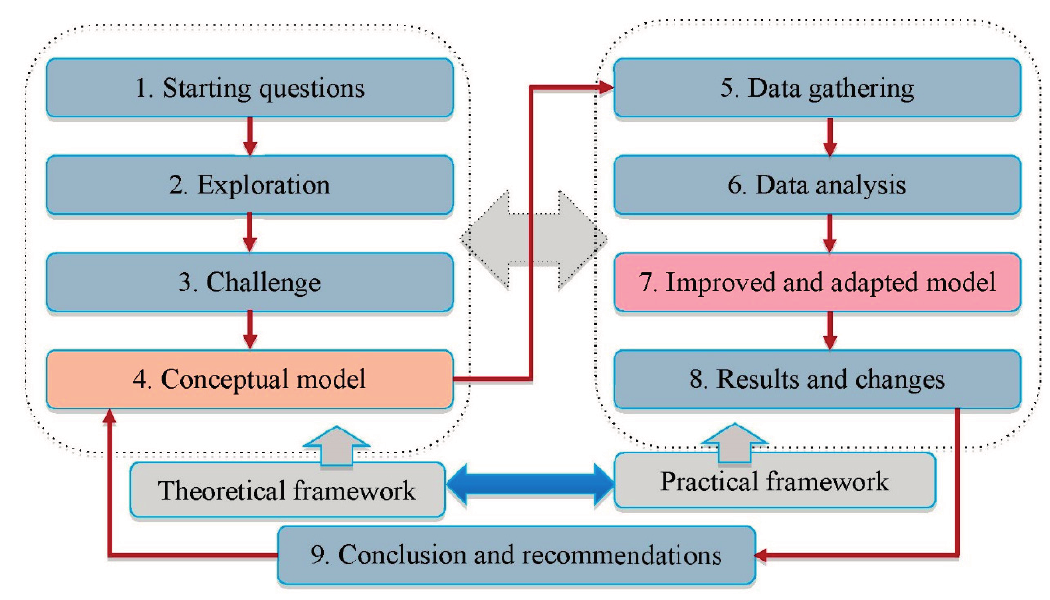
Figure 7. Proposed methodological